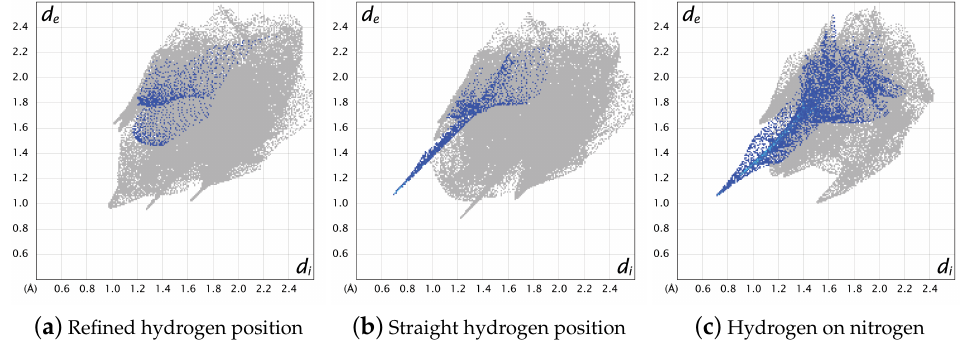
Figure 7. Fingerprint plots with the highlighted H-N interactions ( a , b ) and H-O ( c ) for the three different configurations assumed by the hydrogen, in the LAG-solved 1:1 structure, as in Figure 2.